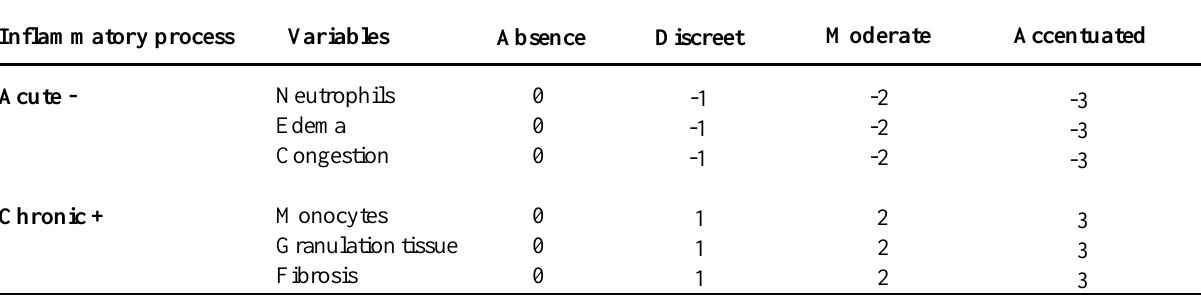
Table 1 – Variables used to obtain the final